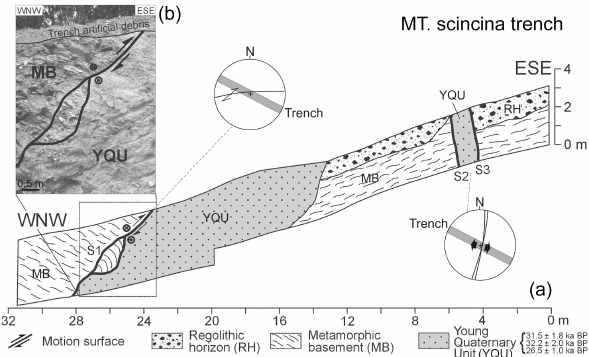
Figure 3. (a) Log of the northern trench wall excavated across the central-upper part of the DSGSD at Mt Scincina (western Alps, Italy; for location see Fig. 2). Note the superimposition of the substratum metamorphic rocks (MB) onto late Quaternary de- posits (YQU) along reverse oblique slip plane S1. S2 and S3 are ex- tensional fractures filled by YQU deposits. Stereograms (Schmidt’s projection, lower hemisphere) show the geometry of slip planes and orientation of the trench. (b) Photo of the reverse oblique fault that puts into contact MB in the hanging-wall block with YQU in the footwall block (modified after Tibaldi et al., 2004).